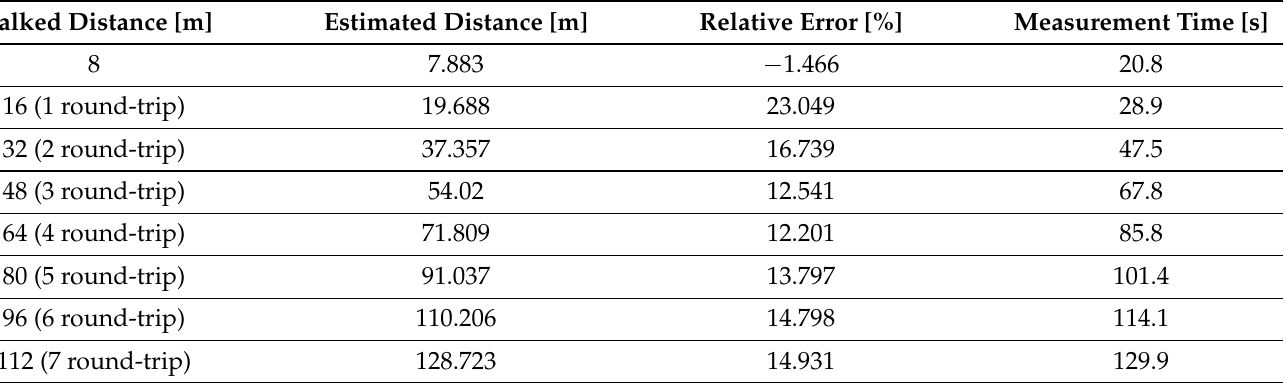
Table 4. The results of route